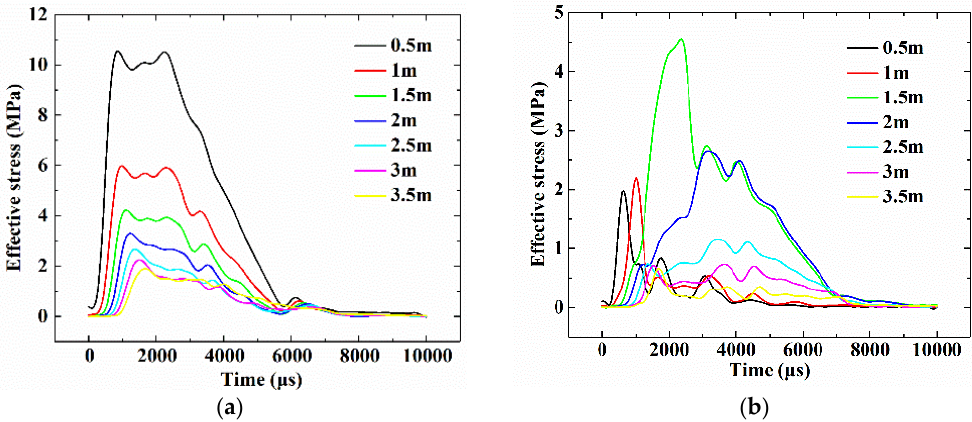
Figure 17. Effective stress curves of monitoring units at different directions: ( a ) Effective stress curves Figure 17. E ff ective stress curves of monitoring units at di ff erent directions: ( a ) E ff ective stress curves in the primary impact direction; ( b ) Effective stress curves in the secondary impact direction. in the primary impact direction; ( b ) E ff ective stress curves in the secondary impact